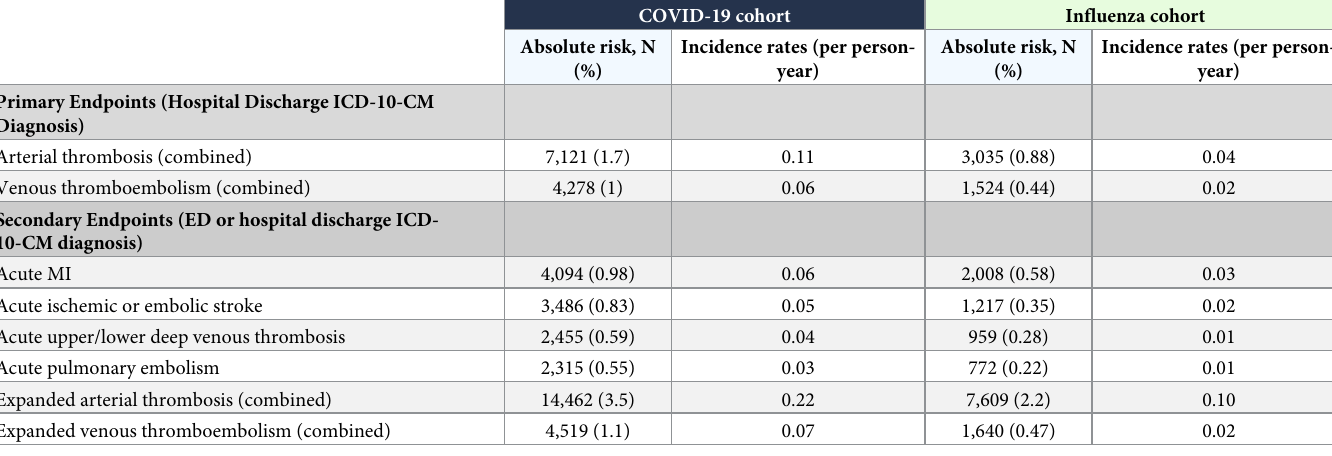
Table 2. Absolute risk and unadjusted incidence rates for primary and secondary outcomes for both